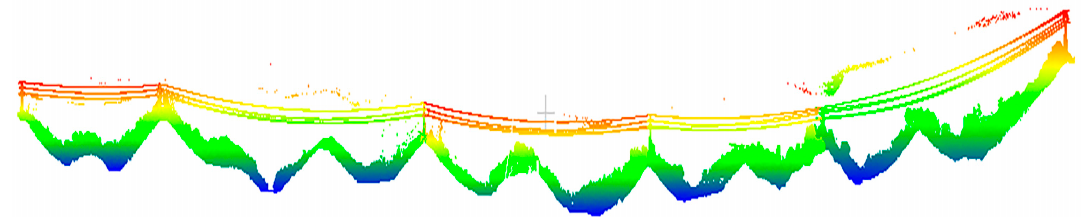
Figure 10. An example area of the original point cloud.